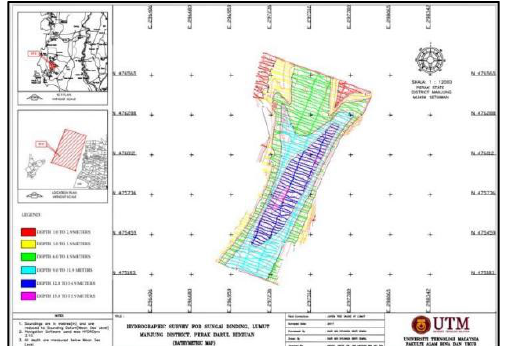
Figure 11. Bathymetric plan relative to the DSMM tide gauge in 2017 plotted using